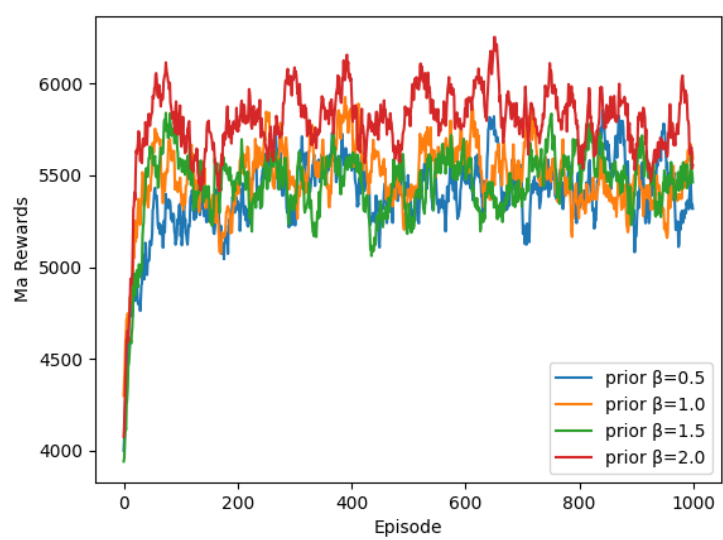
Figure 3. Evaluation with different algorithms.